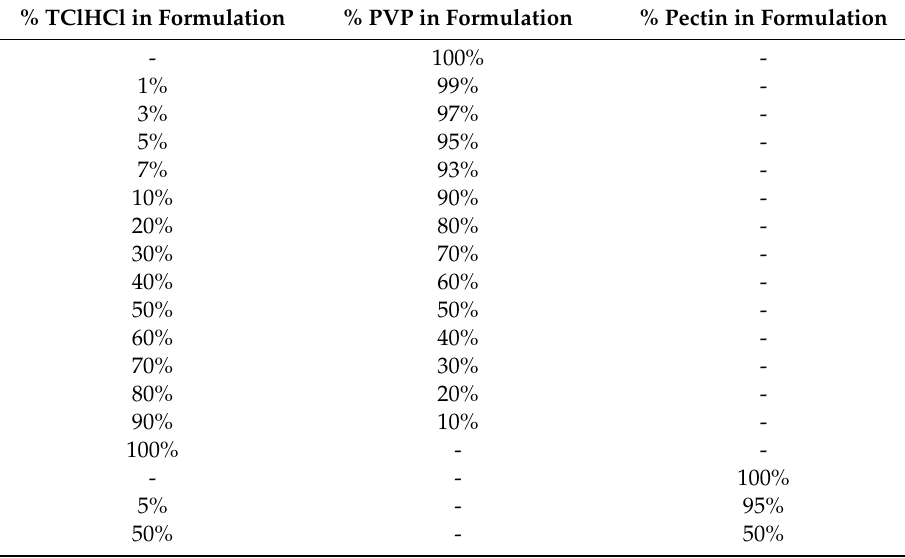
Table 5. Formulations of all TClHCl solid dispersions investigated in this